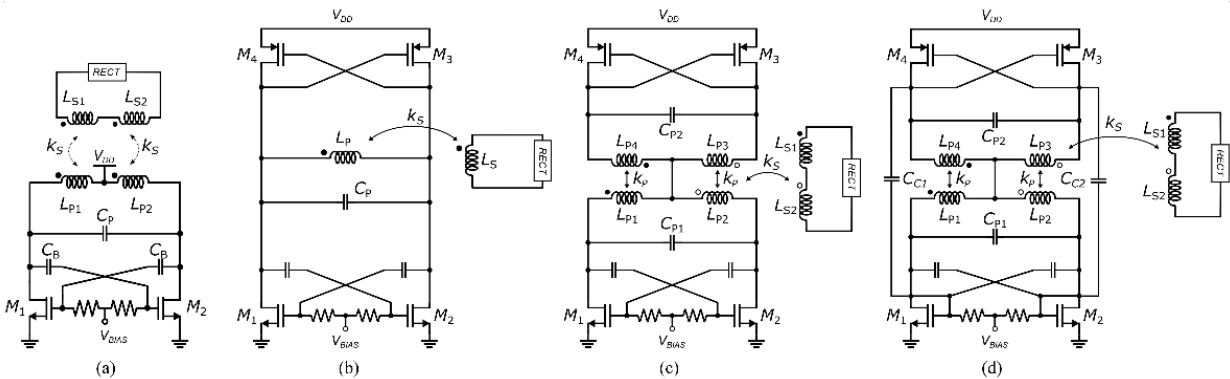
Figure 3. Power oscillator topologies for DC-AC conversion: ( a ) D -class oscillator; ( b ) complementary cross-coupled oscillator; ( c ) inductively coupled CR oscillators; ( d ) hybrid-coupled CR oscillator.